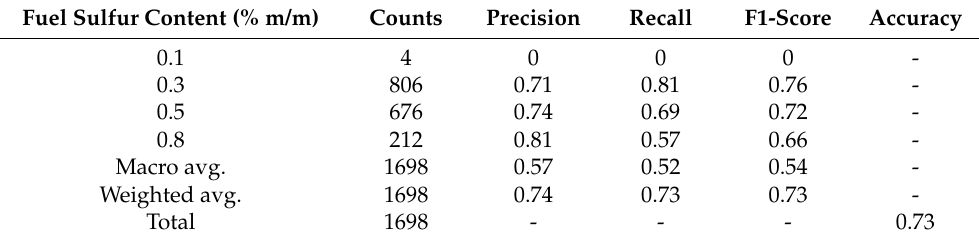
Table 3. Model evaluation report for 300 nm.